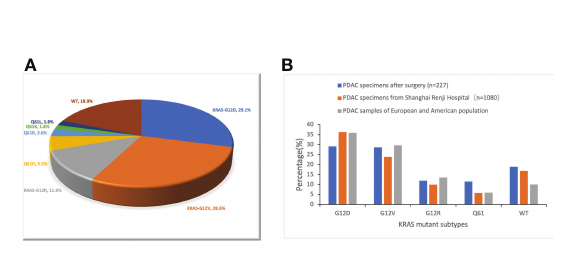
FIGURE 1 Frequency distribution of KRAS mutation subtypes in pancreatic cancer patients. (A) Distribution of KRAS mutations in 227 PDAC surgical samples from Hunan Provincial People ’ s Hospital. WT, KRAS wild type. (B) Differences in the frequency distribution of KRAS subtypes. Blue represents the data of our study. Not only surgical samples, but also needle biopsy samples of advanced PDAC, are included in the analysis of KRAS subtype distribution in the Shanghai Renji Hospital, European, and American